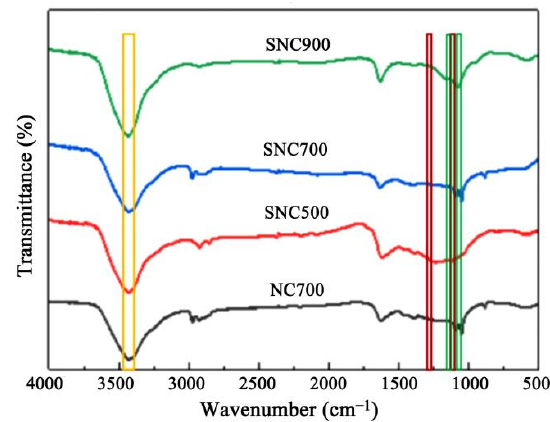
Figure 4. FT-IR spectra of NC and SNC at different carbonization temperatures.